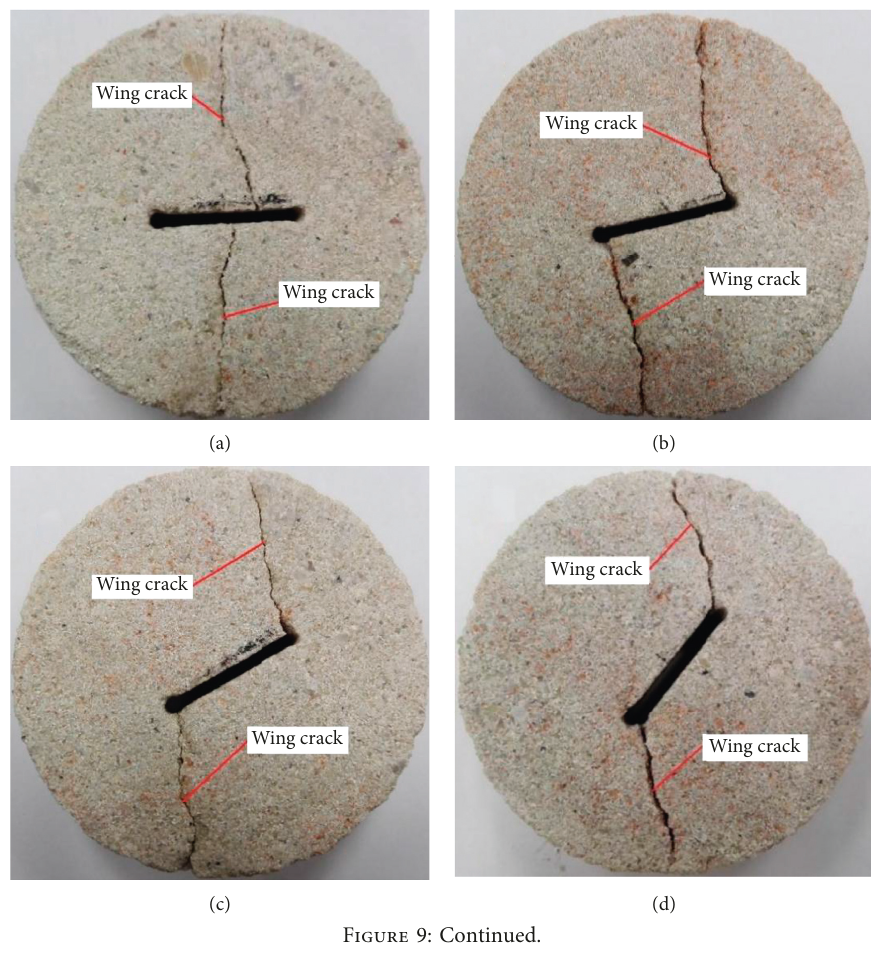
Figure 8: Crack propagation paths in fine sandstone CSCFBD specimens with different inclination angles of pre-cracks: (a) β 45 ° ; (e) β 60 ° ; (f) β 75 ° ; (g) β 90 ° (c) β 30 ° ; (d) β (cid:31) (cid:31) (cid:31) (cid:31) (cid:31)